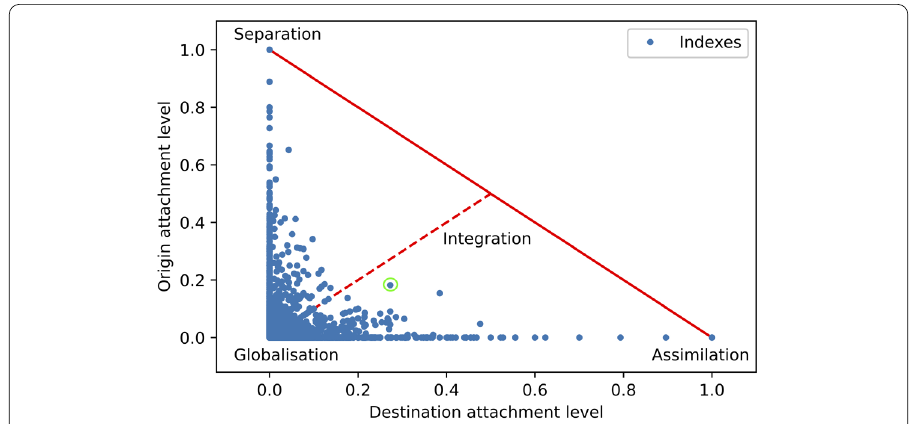
Figure 5 Pearson correlation between origin and destination attachment indices for all the migrants in the data: correlation coefficient: –0.13, p-value: 6.937e –14